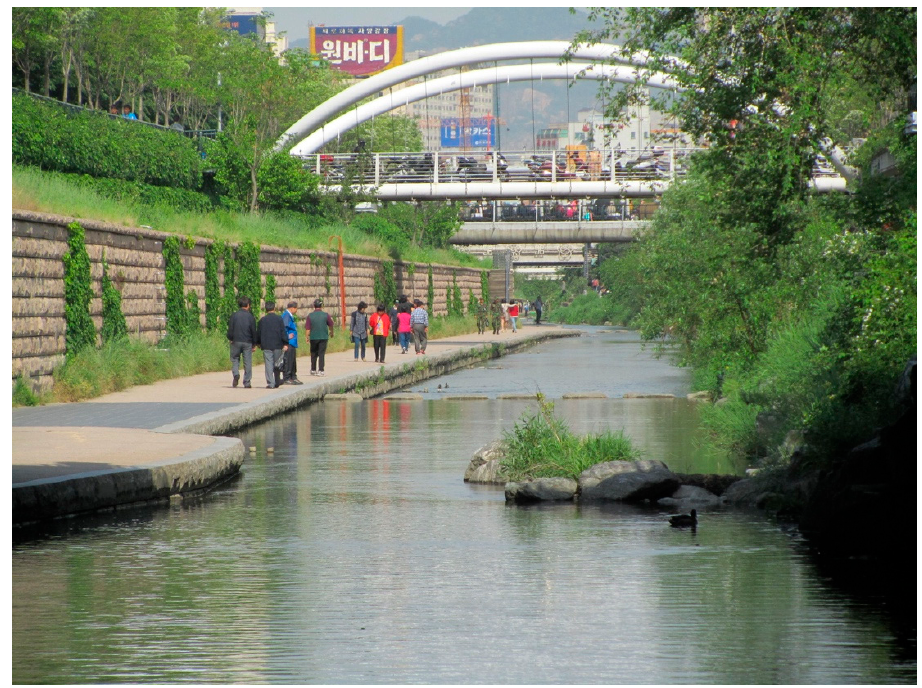
Figure 30. Seoul’s Cheonggyecheon restoration project after freeway removal, resulting in improved not worsened traffic speed. Source: Jeffrey Kenworthy.